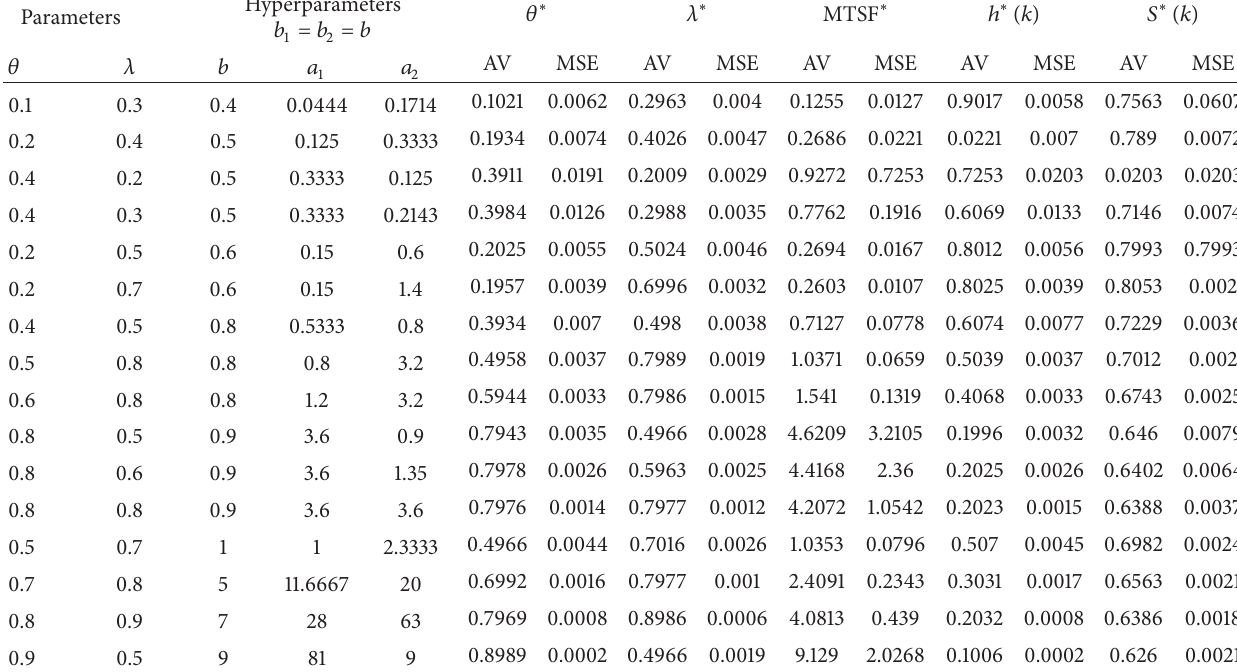
Table 8: Bayes estimates under LINEX loss function.